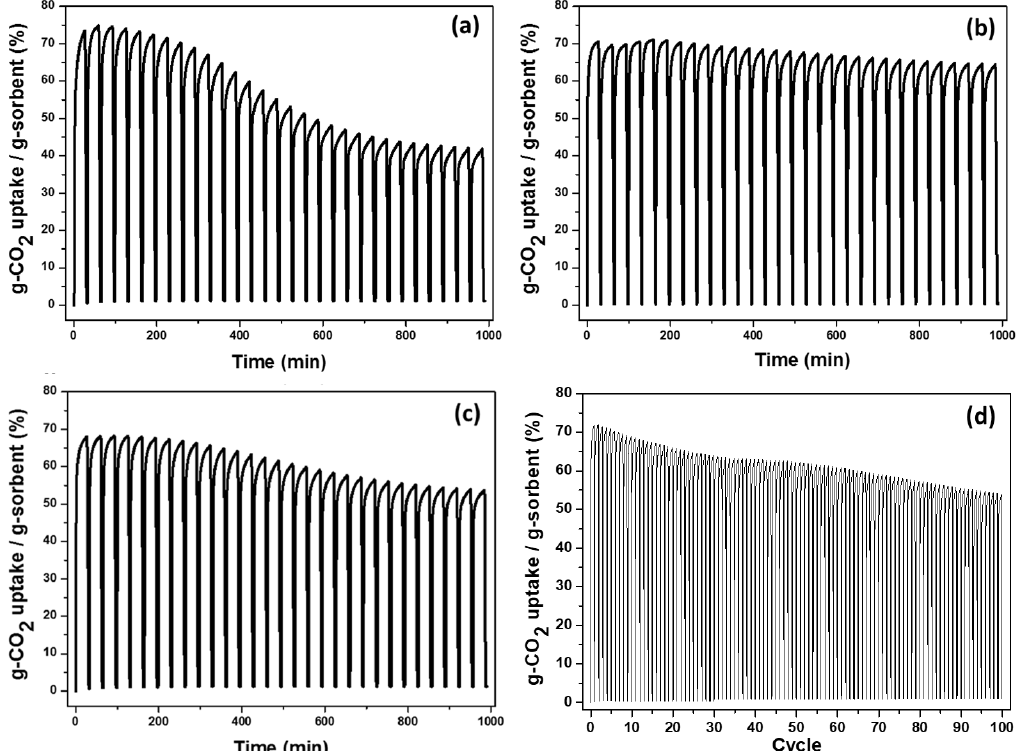
Figure 8. CO 2 -uptake of multiple carbonation-calcination cycles of ( a ) Ca 0.97 Mg 0.03 -MOF-O, ( b ) Ca 0.97 Mg 0.025 Al 0.005 -MOF-O, ( c ) Ca 0.97 Mg 0.015 Al 0.015 -MOF-O, and ( d ) CO 2 -uptake of 100 carbonation-calcination cycles of Ca 0.97 Mg 0.025 Al 0.005 -MOF-O.